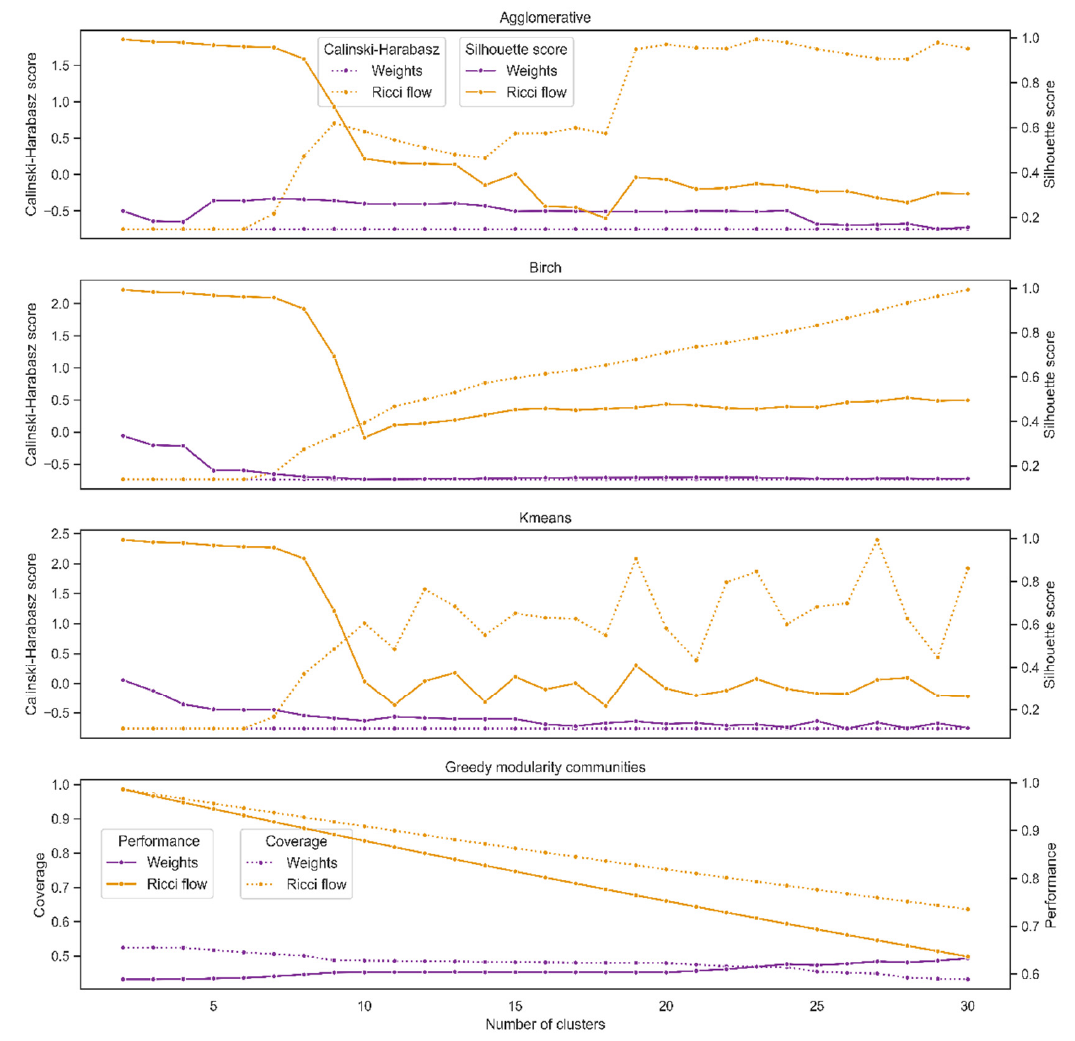
Figure 3. The clustering performance of the Forman–Ricci flow metric compared to graph weights for four different cluster algorithms and two internal validity scores.